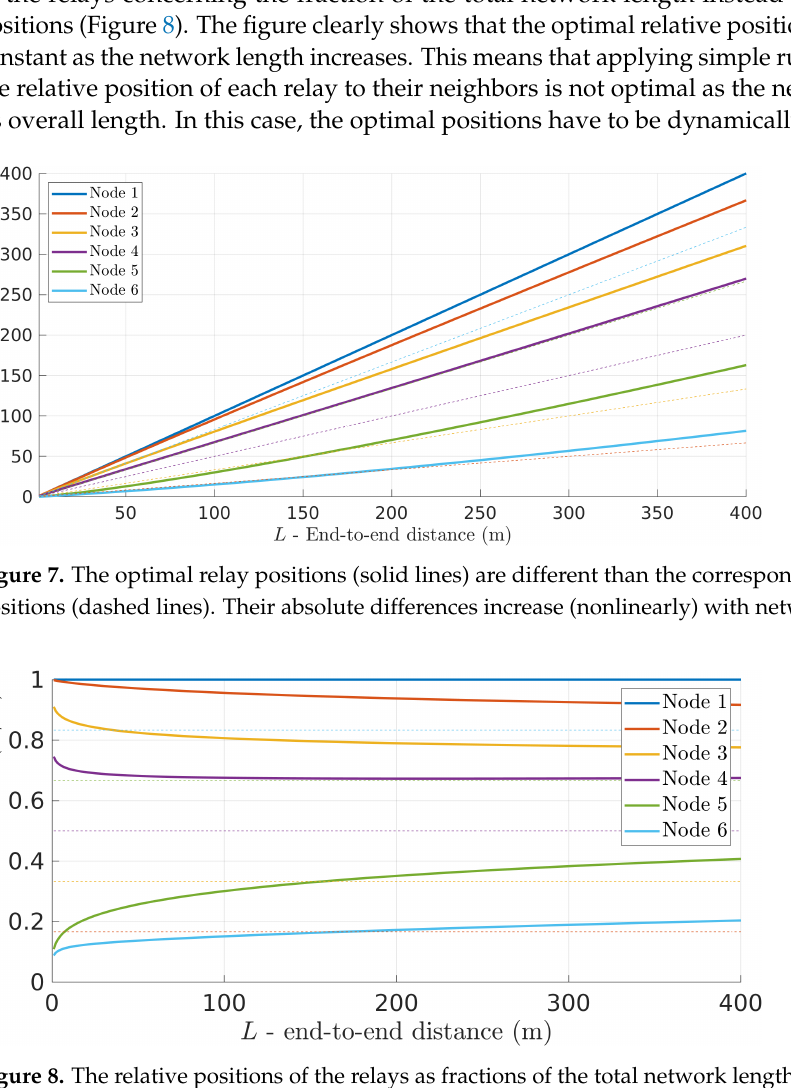
Figure 8. The relative positions of the relays as fractions of the total network length change with the network length